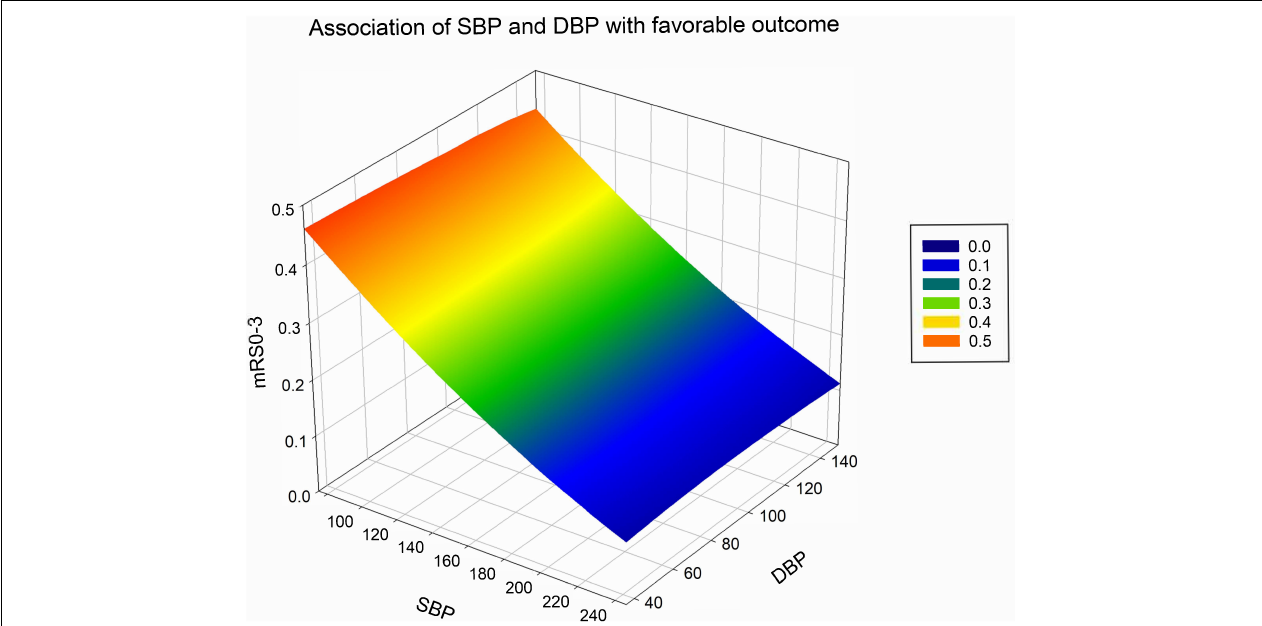
FIGURE 4 | Association of SBP and DBP with the probability of a favorable outcome at 90 days after basilar artery occlusion. Favorable outcome probability reduces both with increases in SBP and DBP. SBP, systolic blood pressure; DBP, diastolic blood pressure.